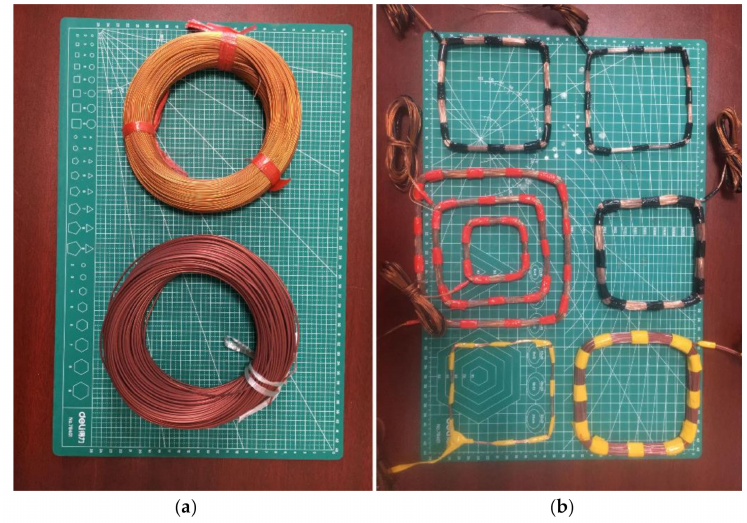
Figure 10. The type of the transmitting coil and the receiving coil. ( a ) Copper metal wire; ( b ) Coil of a certain